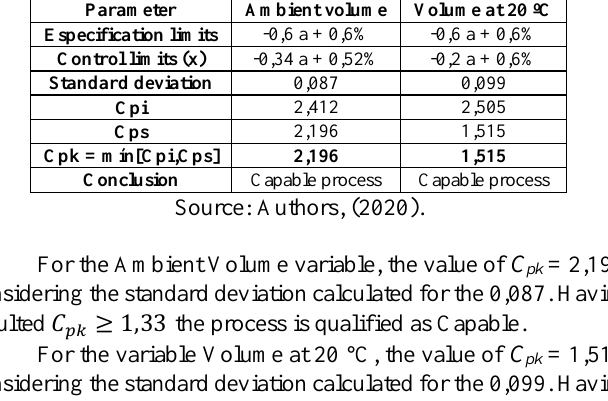
Table 6: Control limits and capacity study (process review).